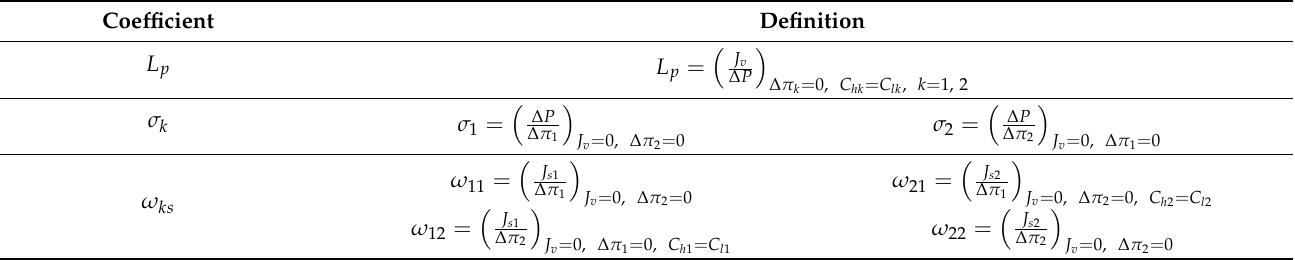
Table A1. Physical interpretation of membrane transport parameters.